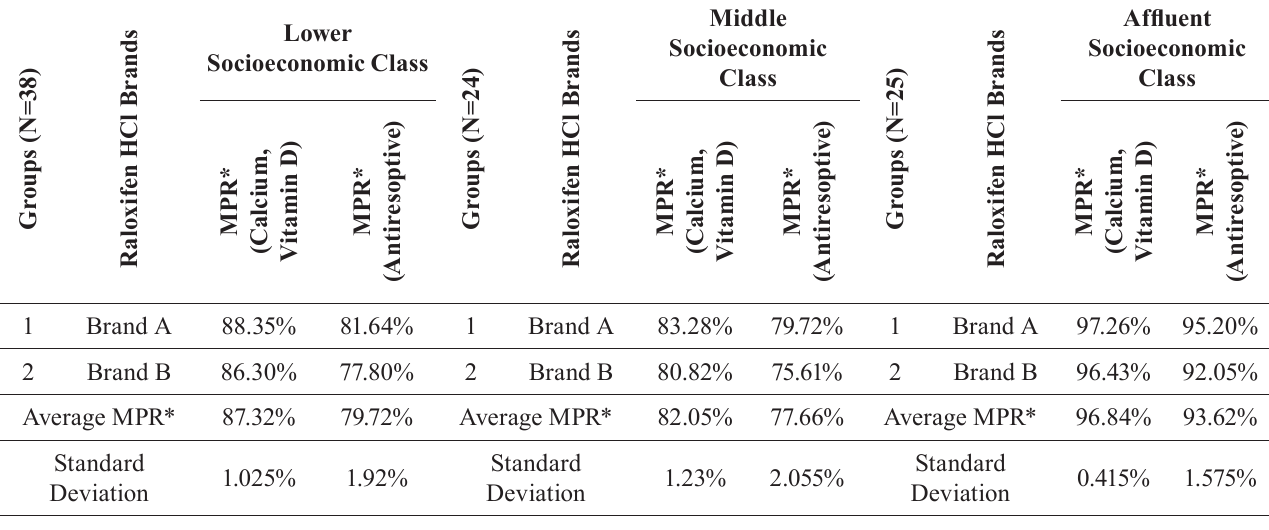
TABLE III - MPR of Raloxifen Brands, Calcium, Vitamin D in different Socioeconomic Classes